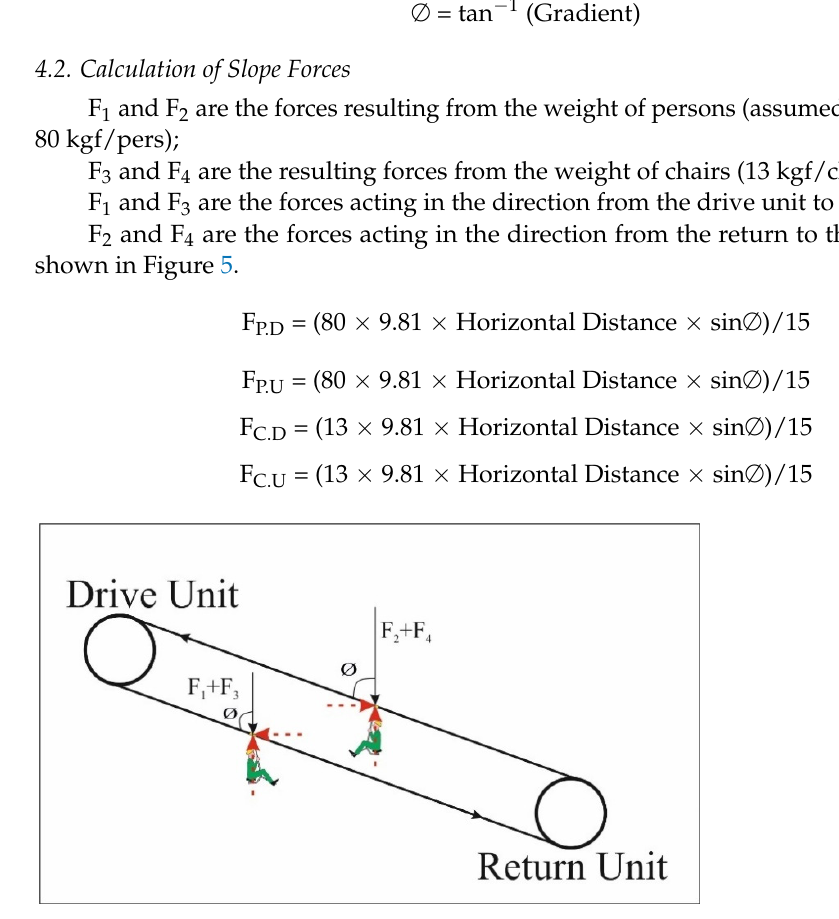
Figure 5. Forces acting on wire rope.